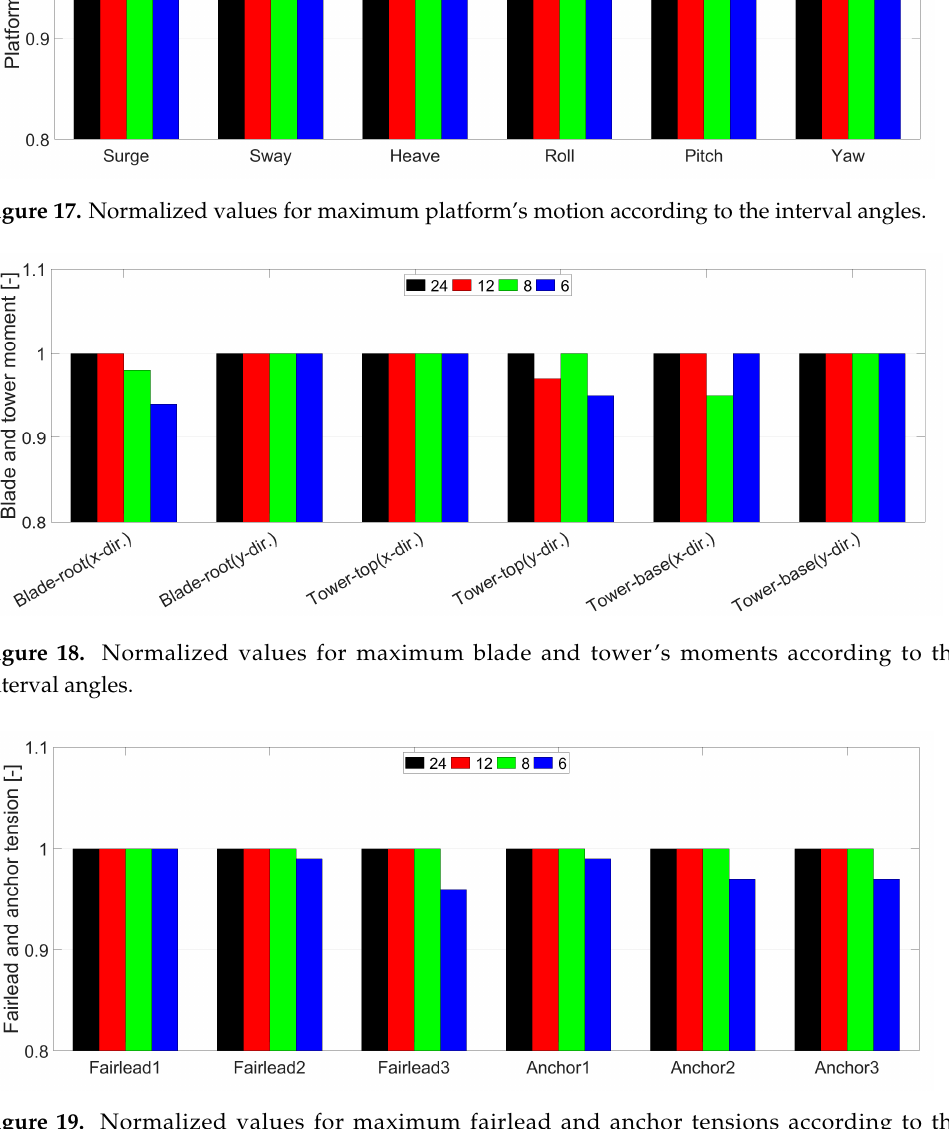
Figure 19. Normalized values for maximum fairlead and anchor tensions according to the interval angles.